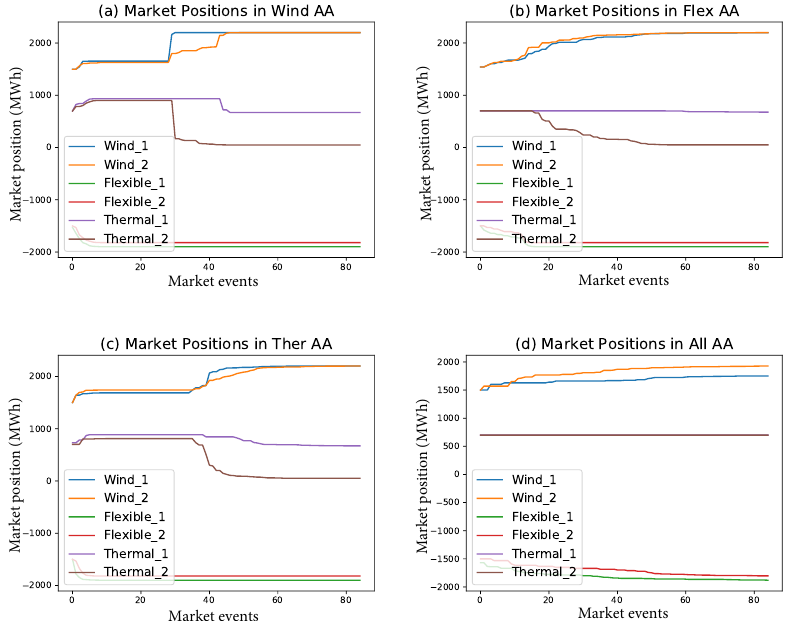
Figure 6. Effect of different price–volume strategies on market positions (in MWh) of the agents in ( a ) Wind AA ; ( b ) Consumer AA ; ( c ) Thermal AA ; and ( d ) All AA with respect to market events.